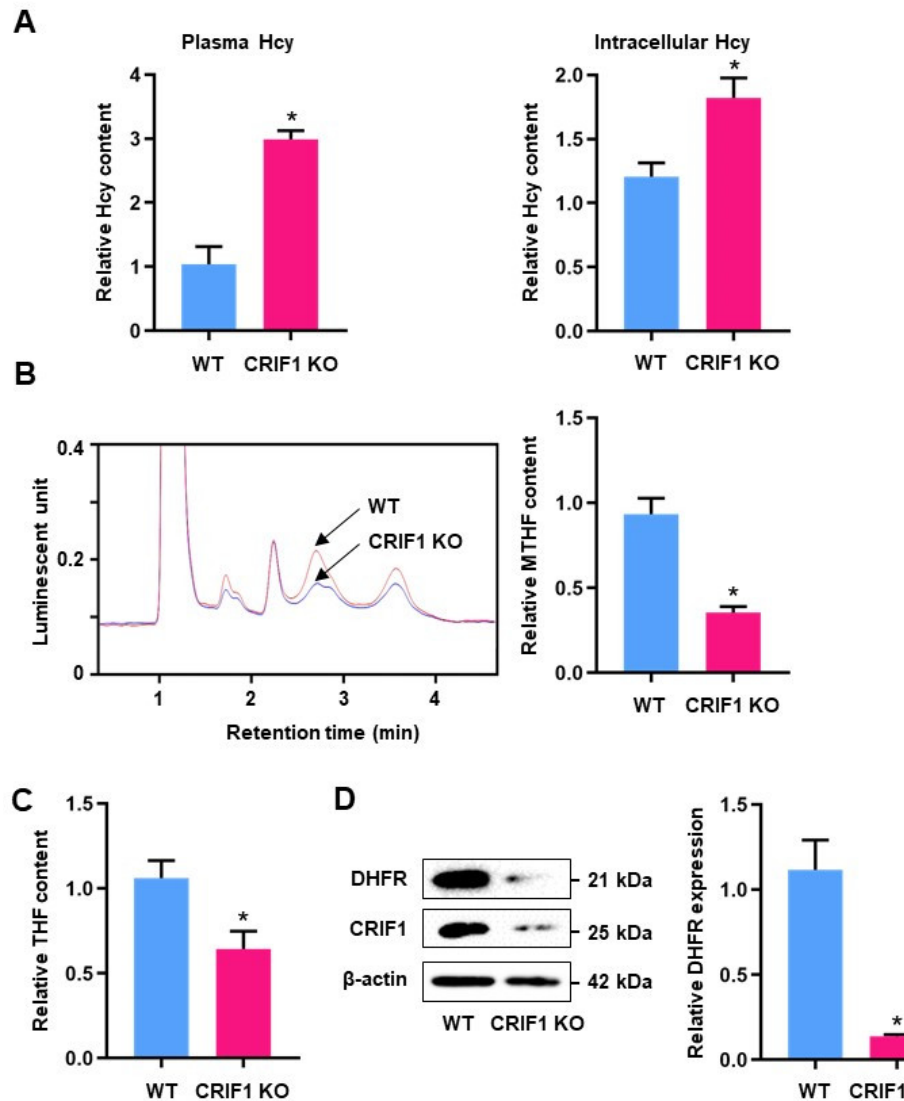
Figure 5. The levels of homocysteine, MTHF, THF, and DHFR expression in mouse endothelial cells. ( A ) Hcy content in lung endothelial cells and plasma from WT and CRIF1 KO mouse were measured. Relative quantitative analysis of the Hcy content is shown as a graph. ( B ) MTHF content of WT and KO endothelial cells were quantified by fluorescent-HPLC. Arrows on the luminescent signal indicate an MTHF peak of WT and CRIF1 KO endothelial cells, and the peak-height-based quantification of MTHF is shown as a graph (right). ( C ) The THF level of endothelial cells isolated from WT and CRIF1 KO mouse was quantified and is shown as a graph. ( D ) Western blot analysis of DHFR expression of WT and KO mouse endothelial cells. DHFR level was quantified densitometrically. Data are presented with three independent experiments as the mean ± SEM. * p < 0.05 compared with WT group.